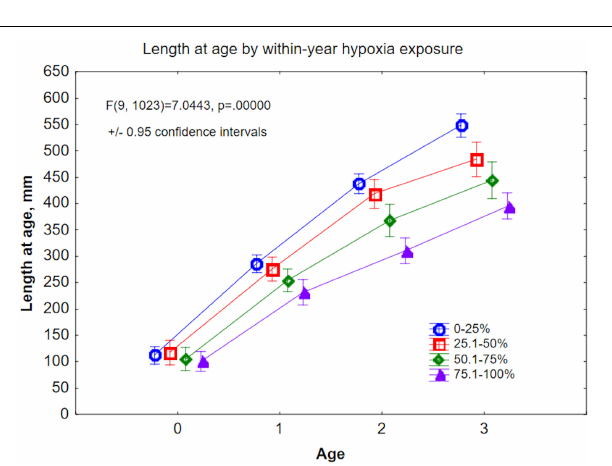
FIGURE 9 | Mean Sr/Ca × 1000, a proxy for salinity, plotted by age for the least and most hypoxia-exposed groups. See Figure 8 for explanation of hypoxia exposure